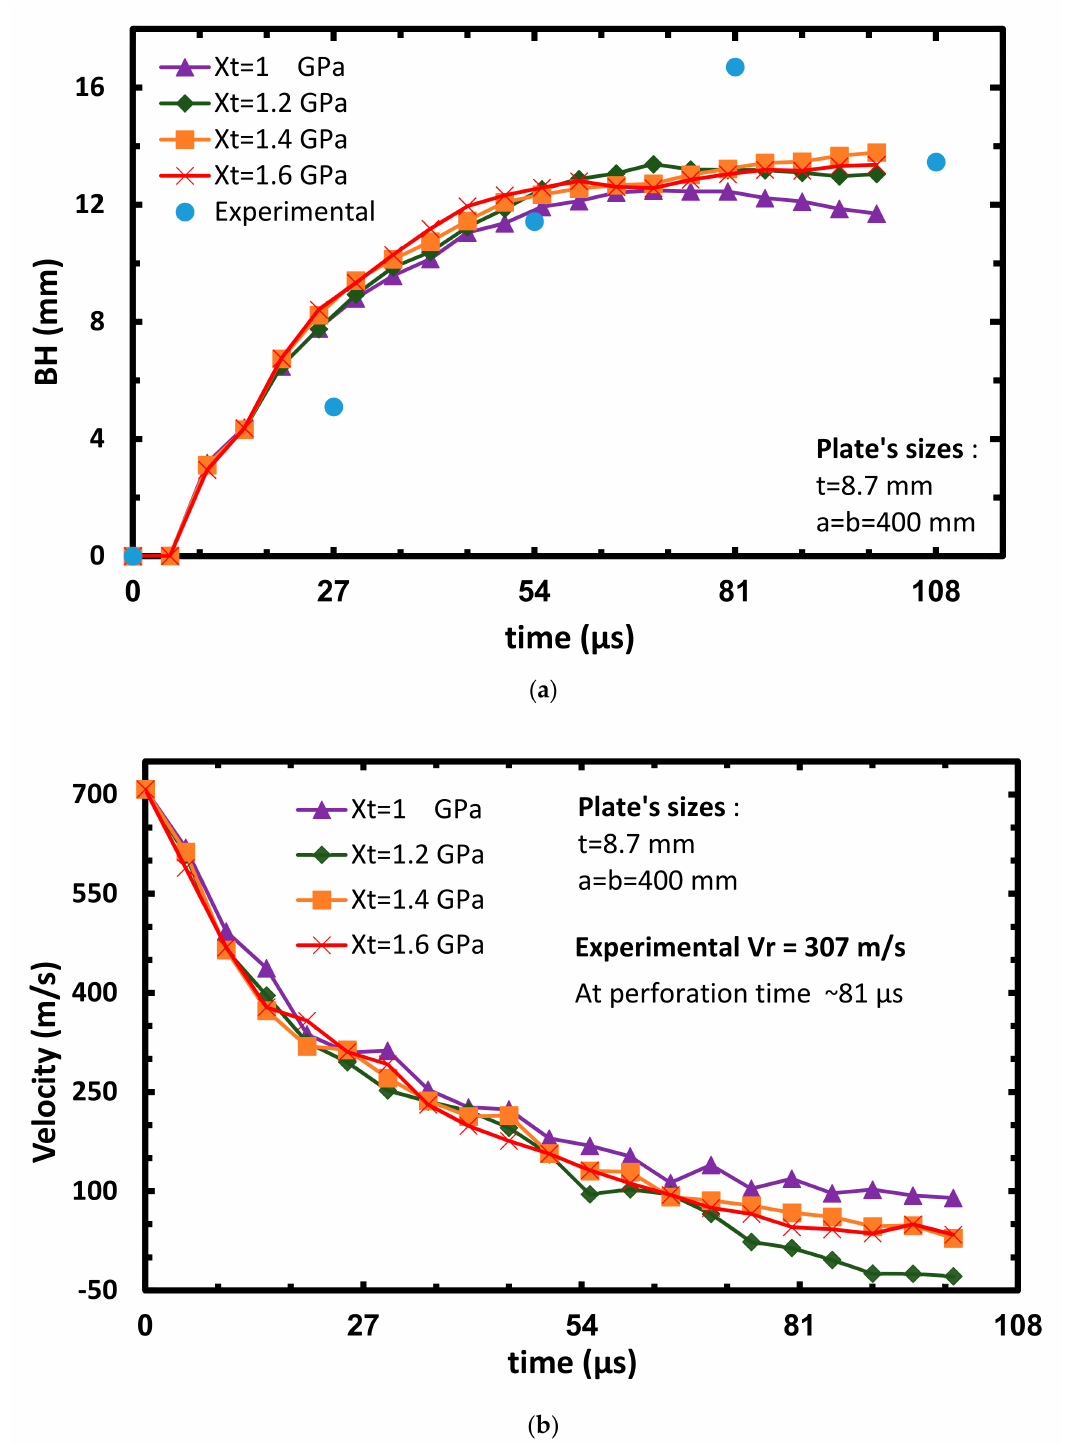
Figure 7. Plate’s bulge height ( a ) and projectile’s velocity ( b ) vs. time at varying Xt, Vinitial = 708 m/s. The deformation at the center back of the plate ( BH ) is given by the displacement–time curves (see Figures 6a and 7a). The shape of the curves of these graphs, describes the loss of the projectile’s kinetic energy, which is absorbed by the target vs. time. The curves represent the displacement of one node on the center back face of the plate along the X axis at varying X t . As can be seen from Figure 6a, after the impact takes place (0–55 µ s), most of the plate’s displacement (~10 mm) occurs and it is close to the displacement obtained